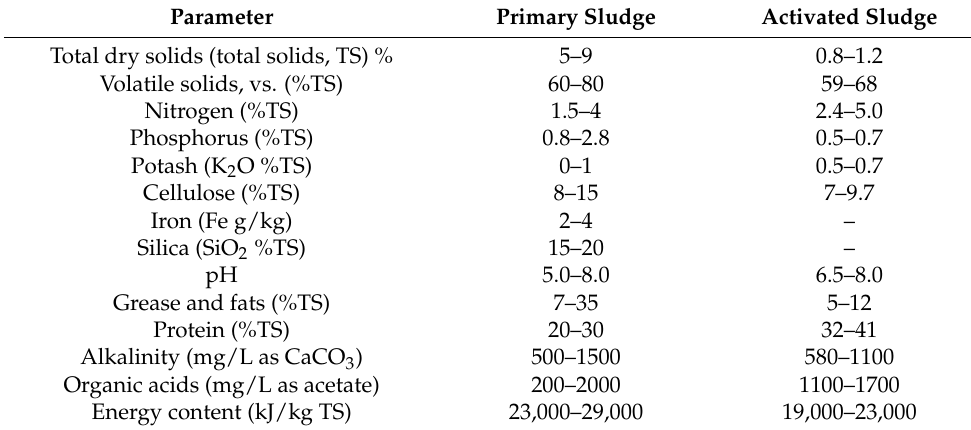
Table 1. Characteristics of two different types of sludge (primary and activated) (data from [25]).